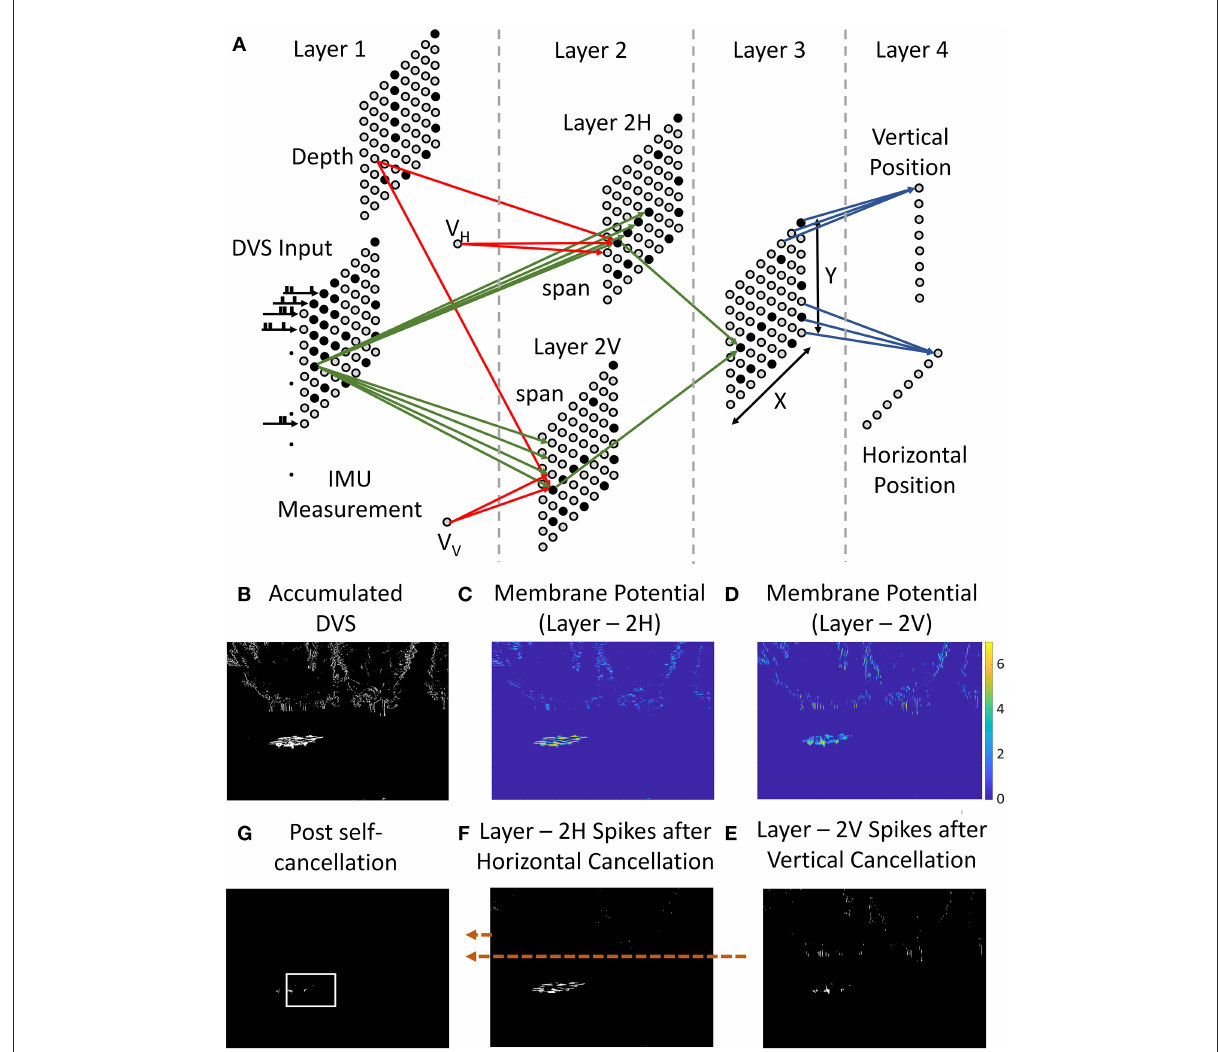
FIGURE3 (A) Four-layer ego-motion filtering SNN. Event-data, self-velocity, and depth information constitute the input and identified position of the prey is provided at the output. (B) Event-accumulated frame within a time window. (C,D) Membrane potential of the neurons in layers 2H and 2V. Patches of continuous event activity cause higher membrane potential build-up. This makes patches of high activity likely to spike more. (E,F) Spikes issued by the 2H and 2V neurons. The prey activity preferentially survives because of the presence of continuous event patches near the prey. (G) Spiking of Layer 3 neurons with AND operation on layer 2V and 2H for SNN output generation.